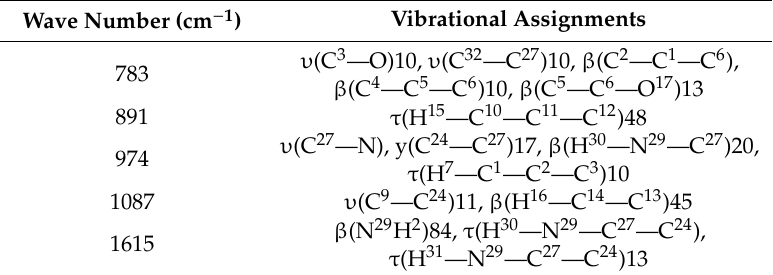
Table 1. Assignments of SERS peak of Thyroxine.